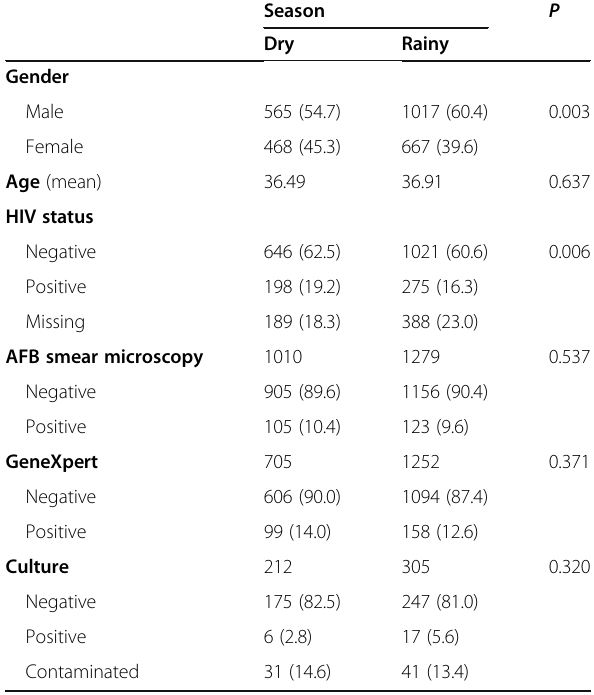
Table 3 Type of TB test performed and result by season